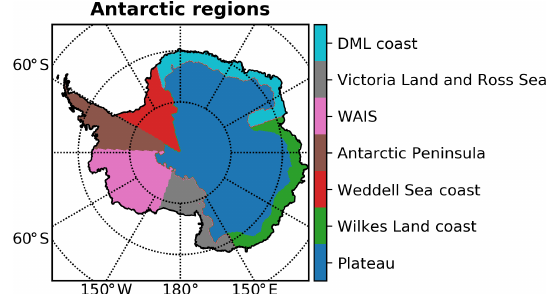
Figure 1. Antarctic regions used in this study. The definitions of the regions are those of Thomas et al.